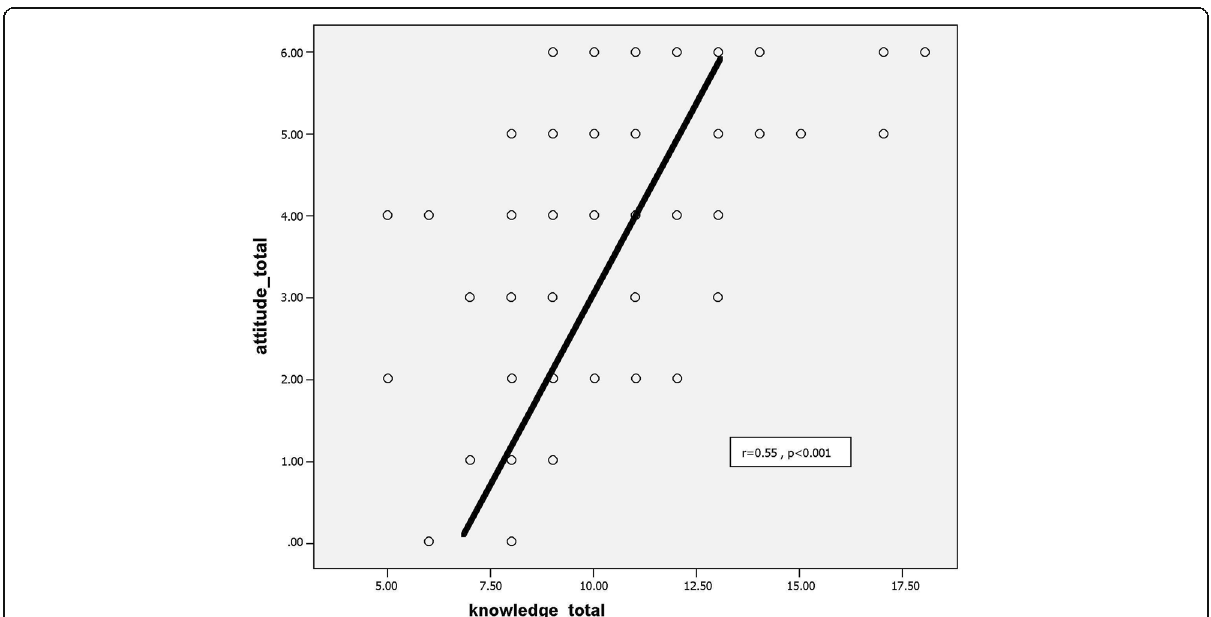
Fig. 1 Correlation between OSA knowledge and attitude scores among Sharkia Governorate Critical Care physicians. OSA, obstructive sleep